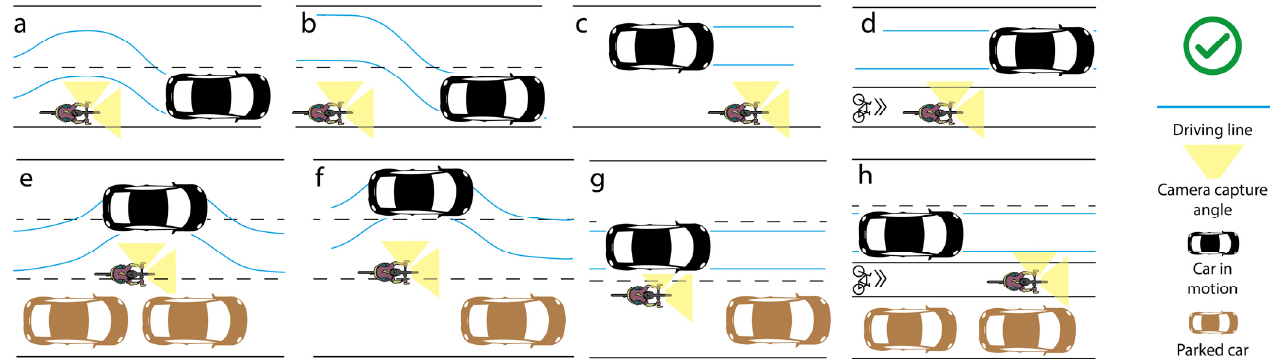
Figure 2. The devices used for collection, attached to the bicycle.